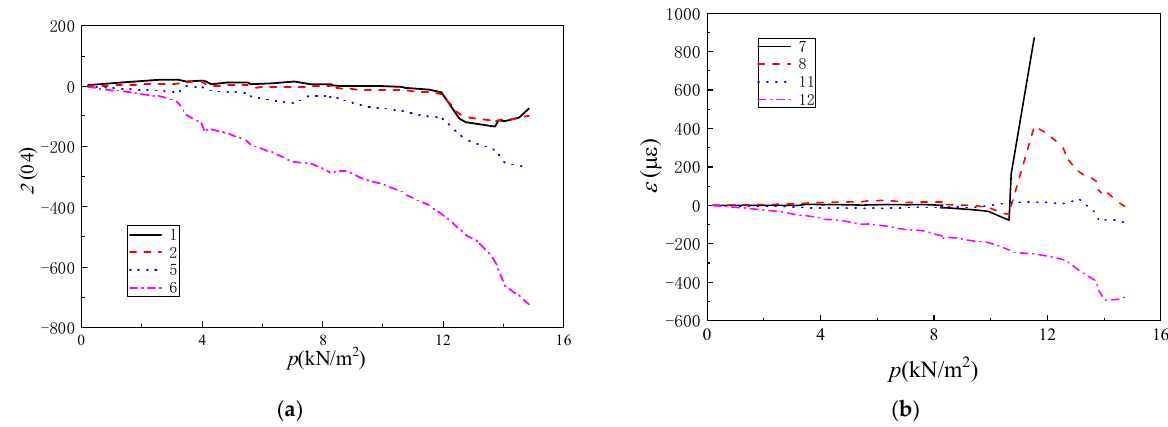
Figure 10. Strains of specimen WP. ( a ) Middle span. ( b ) 1/4 span.